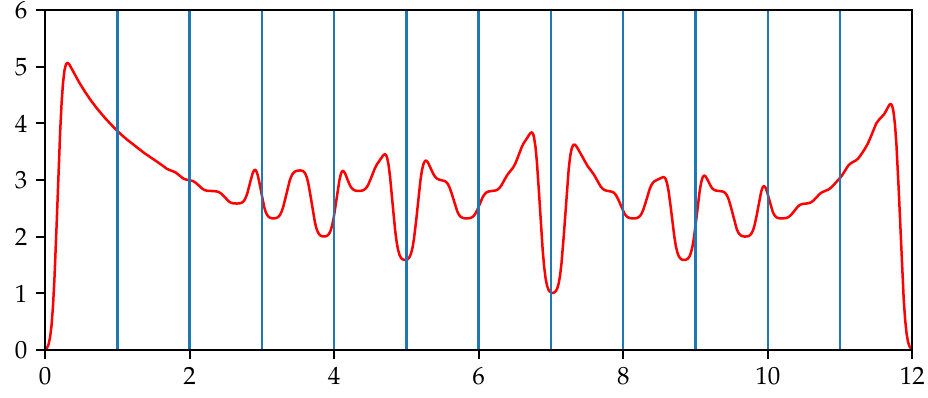
Figure 8. Logarithmic periodicities smoothed by a Gaussian with standard deviation of σ = JND/3 = 6